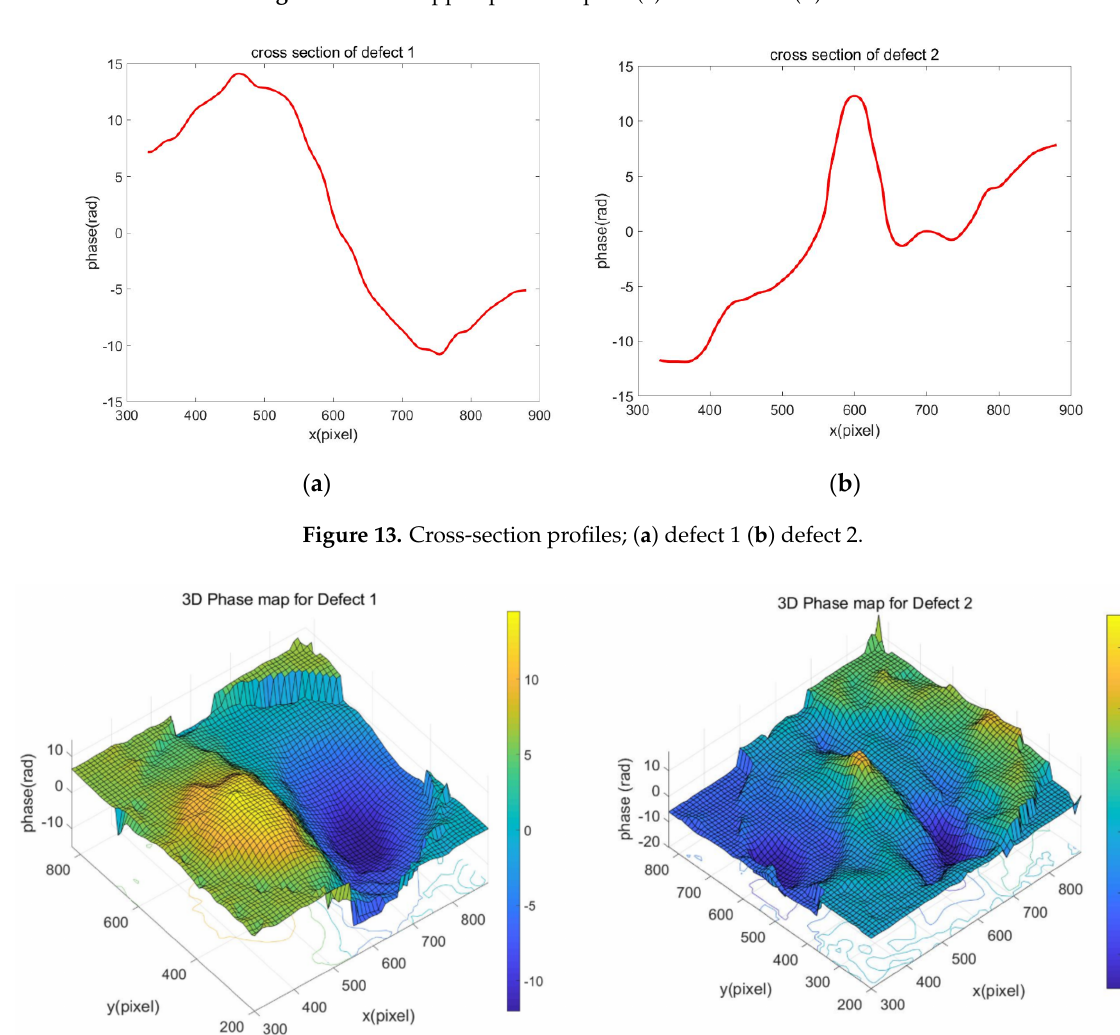
Figure 14. 3D phase maps for ( a ) defect 1 and ( b ) defect 2.